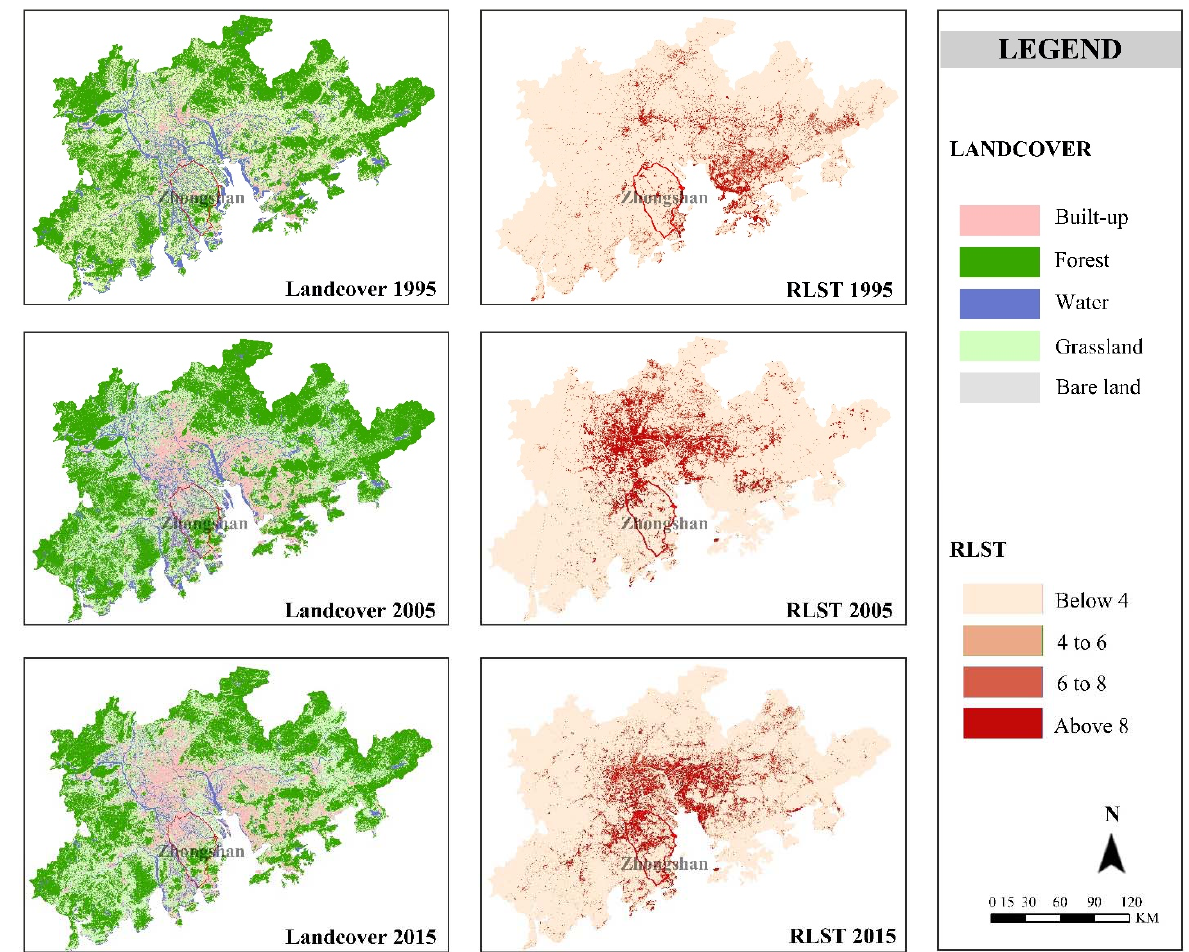
Figure 4. Land cover and the relative land surface temperature (RLST) maps of the PRDR from 1995 to 2015.